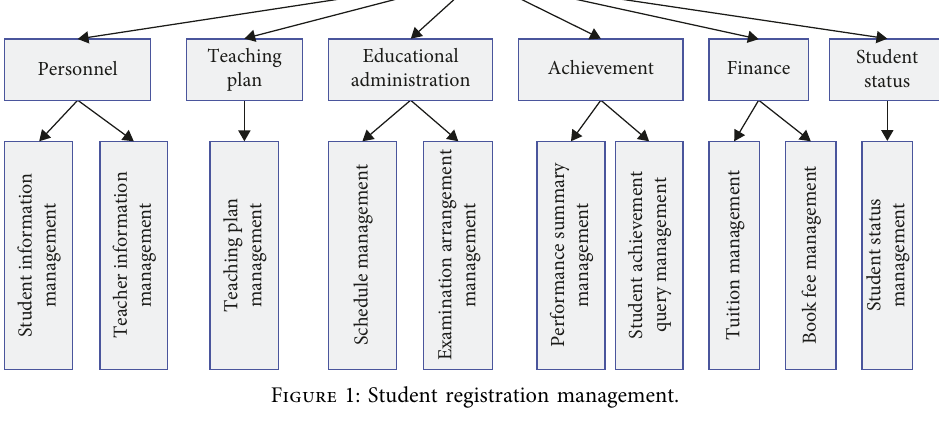
Figure 1: Student registration management.